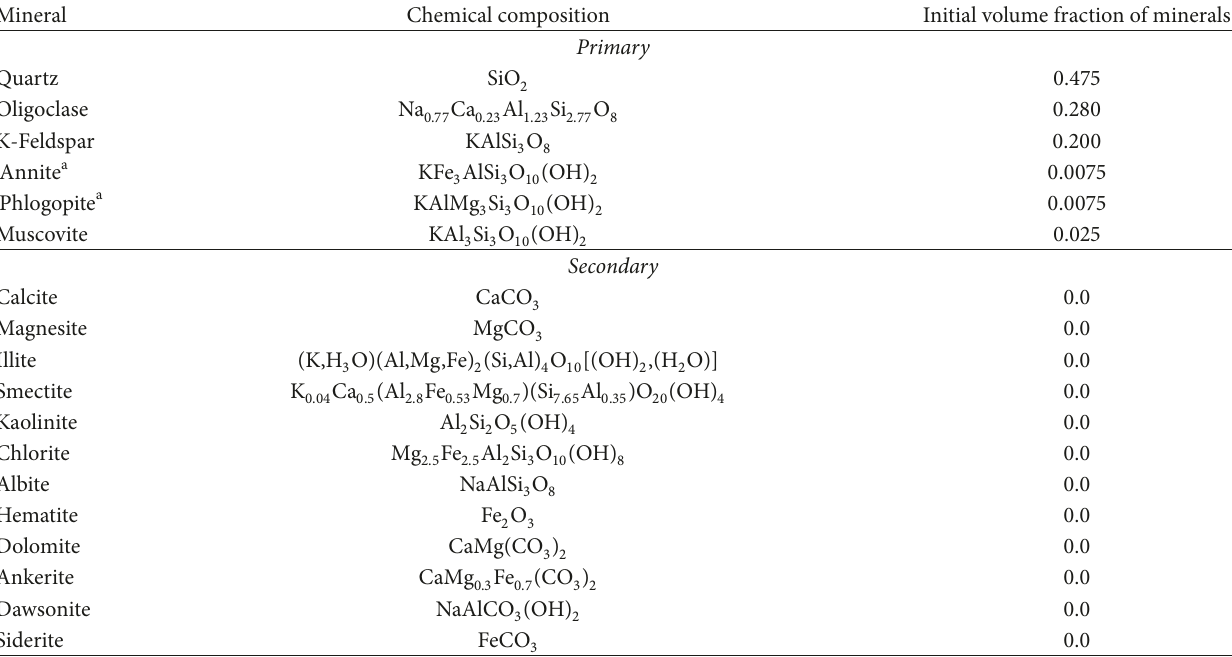
Table 3: Chemical composition and initial volume fractions of primary and secondary minerals for geochemical simulations of the St. John’s CO 2 field site.